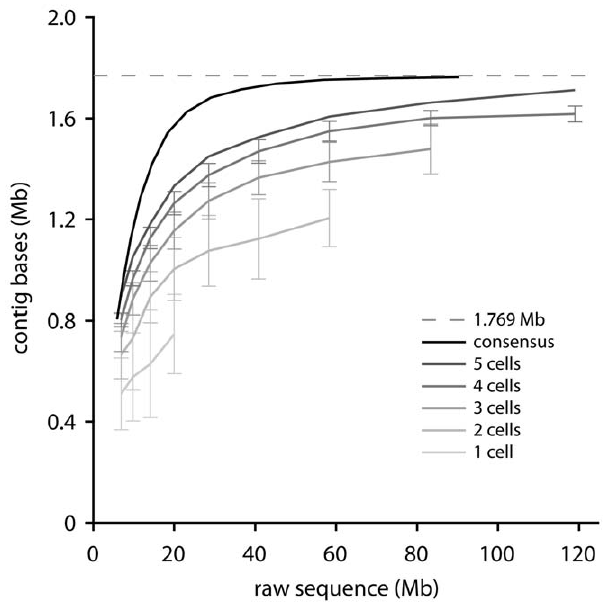
Figure 2. Assembly of the N. limnia datasets. Rarefaction analysis of the N. limnia sequence data showing assembly of the consensus dataset and as a function of the number of included single-cells.